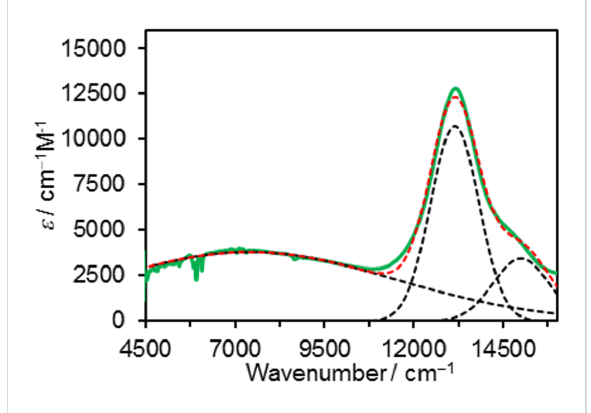
Figure 5: Vis-NIR spectra of 1b + (green line) obtained by bulk electrol- ysis, with Gaussian deconvolutions (black broken lines) and the sum (red broken line).